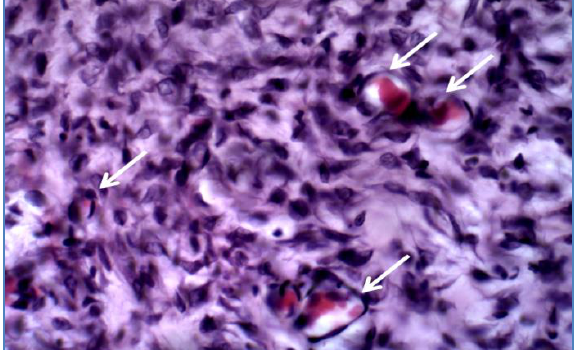
Figure, 10: Section of skin (14 days-control) shows epidermis (arrow), dermis (D), hair follicle (Hf), and normal area (Na) H and E, 40x.